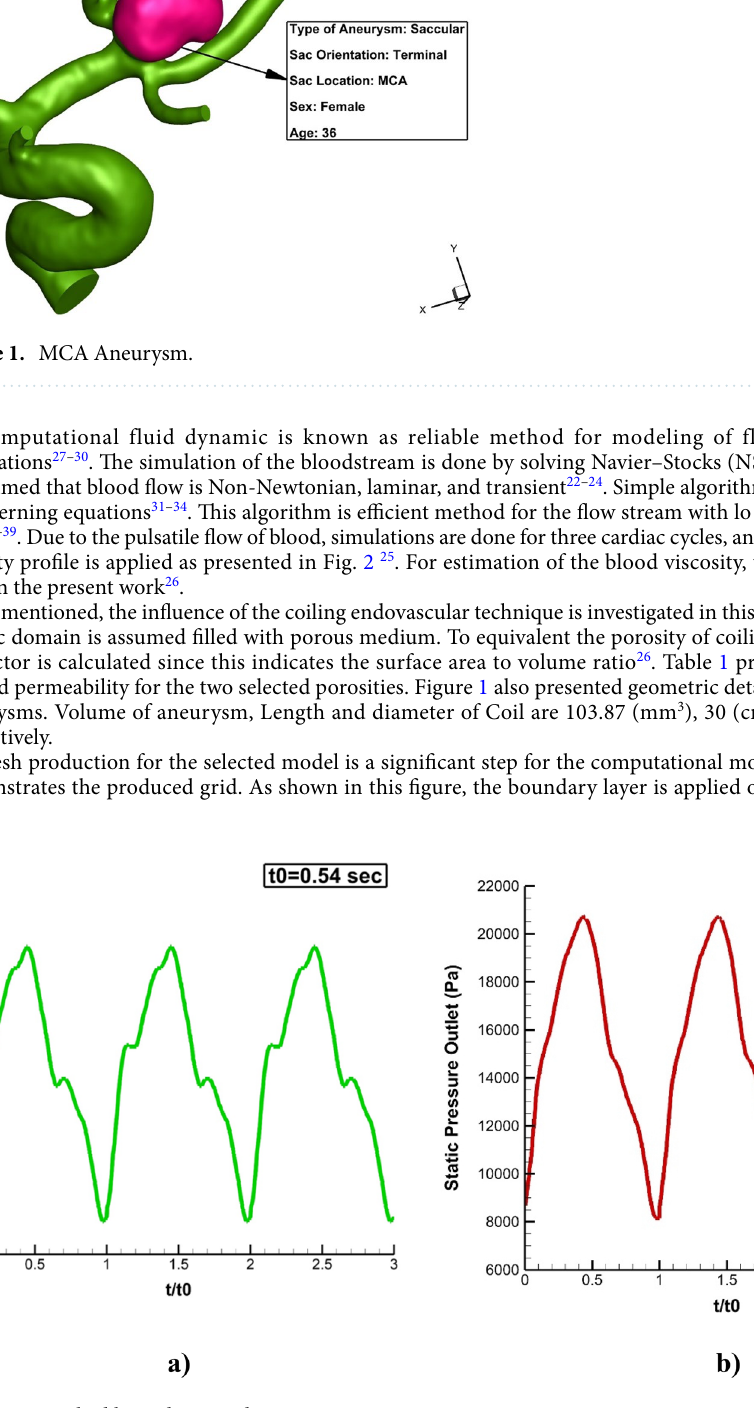
Figure 2. Applied boundary condition.